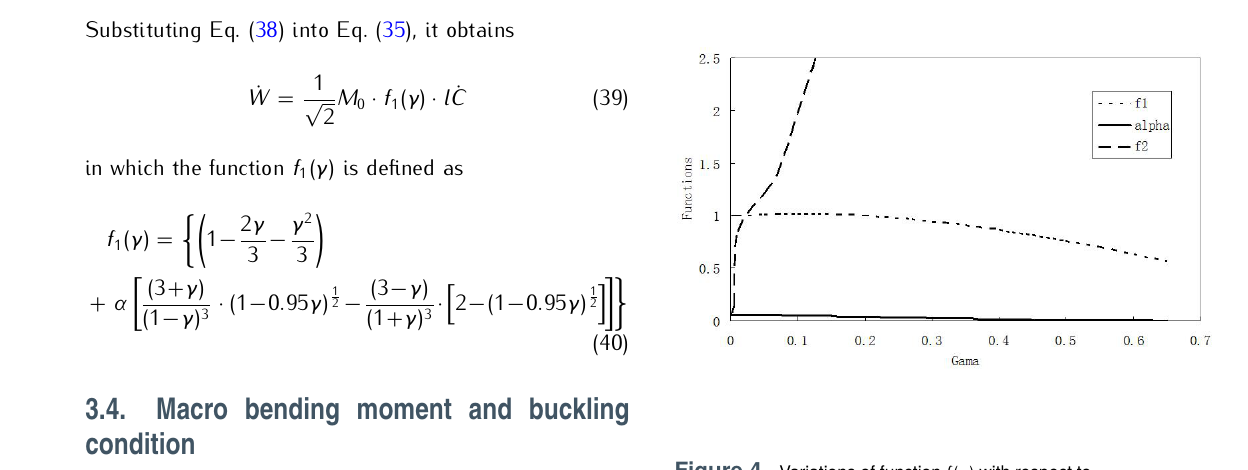
( γ ) with respect to γ